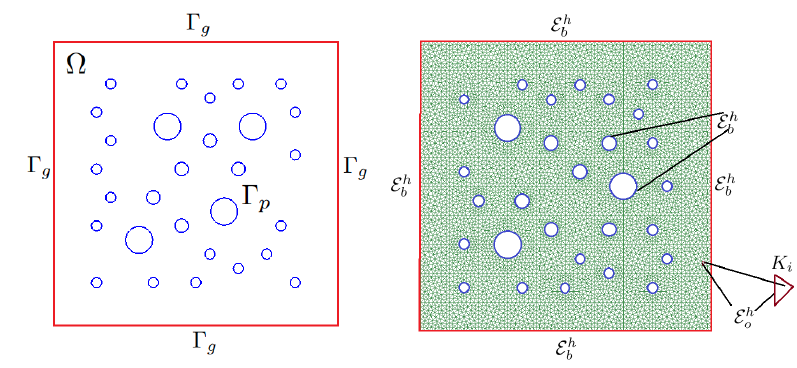
Figure 1. Illustration of perforated domain Ω ( left ) and fine grid T h ( right